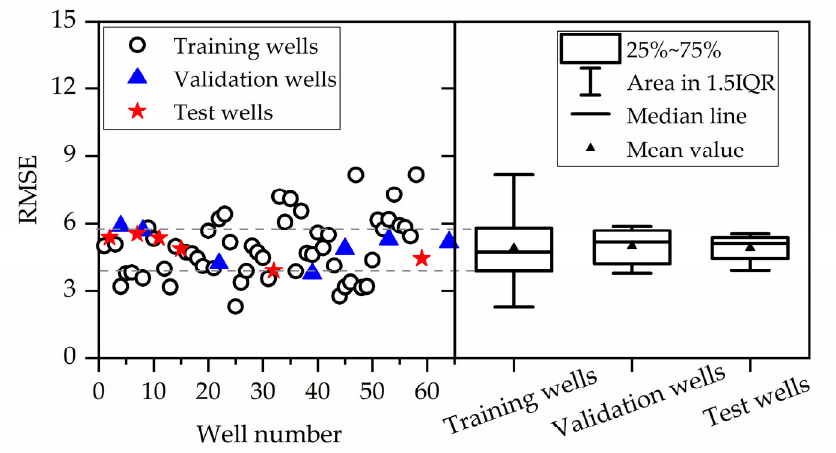
Figure 9. Root mean square error (RMSE) of predicted results with the SingleStep approach.